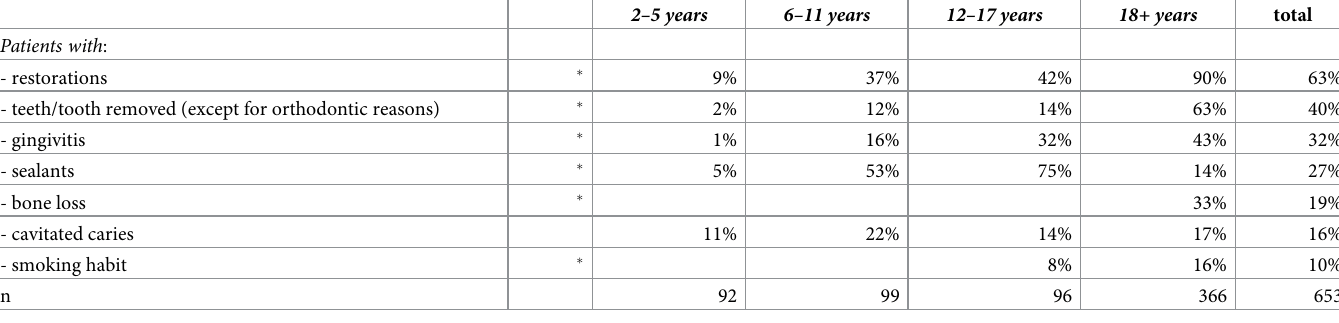
Table 3. Clinical evaluation of the patients’ oral health, provided by the